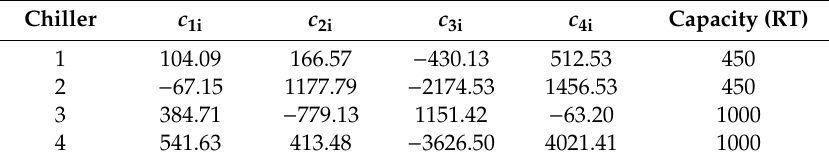
Table 2. Chiller data in case 2.